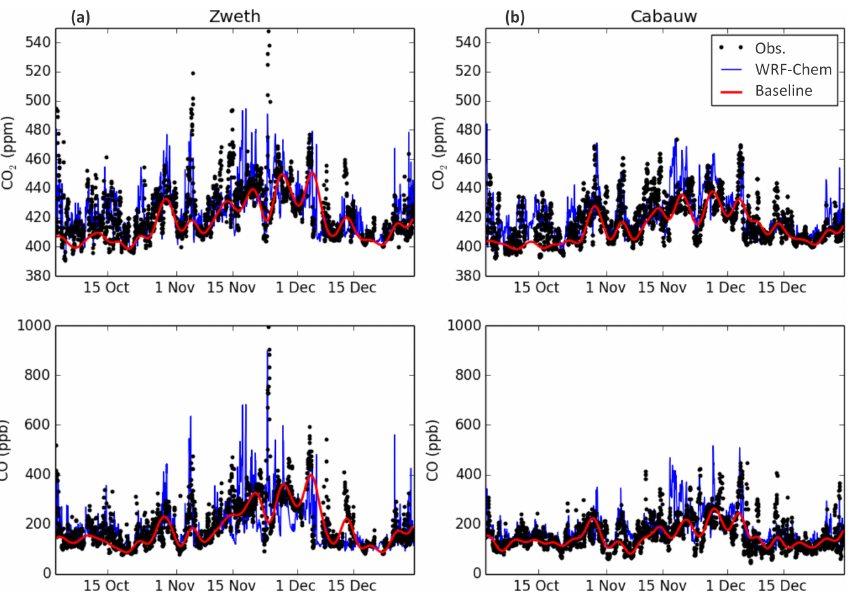
Figure 3. Time series of modelled (WRF-Chem) and observed CO 2 and CO mixing ratios at Zweth (a) and Cabauw (b) . The observation- based baseline used in this study is also shown.